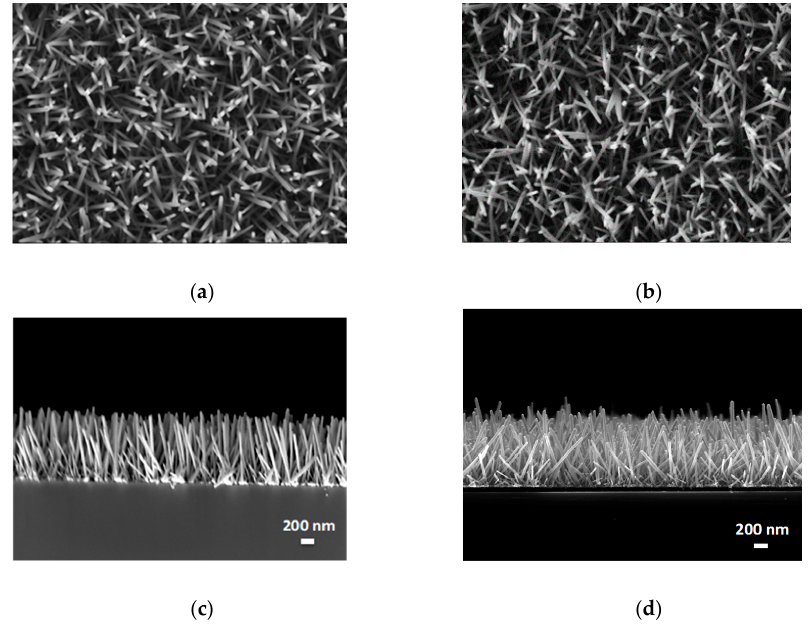
Figure 2. Plane-view and cross-section scanning electron microscopy (SEM) images of the undoped ZnO NWs ( a , c ) and Fe-doped ZnO NWs ( b , d ) obtained via hydrothermal method with growth time of 4 h at 95 °C.